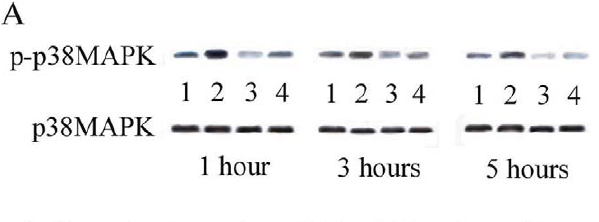
differences from baseline in the p38 MAPK phosphorylation